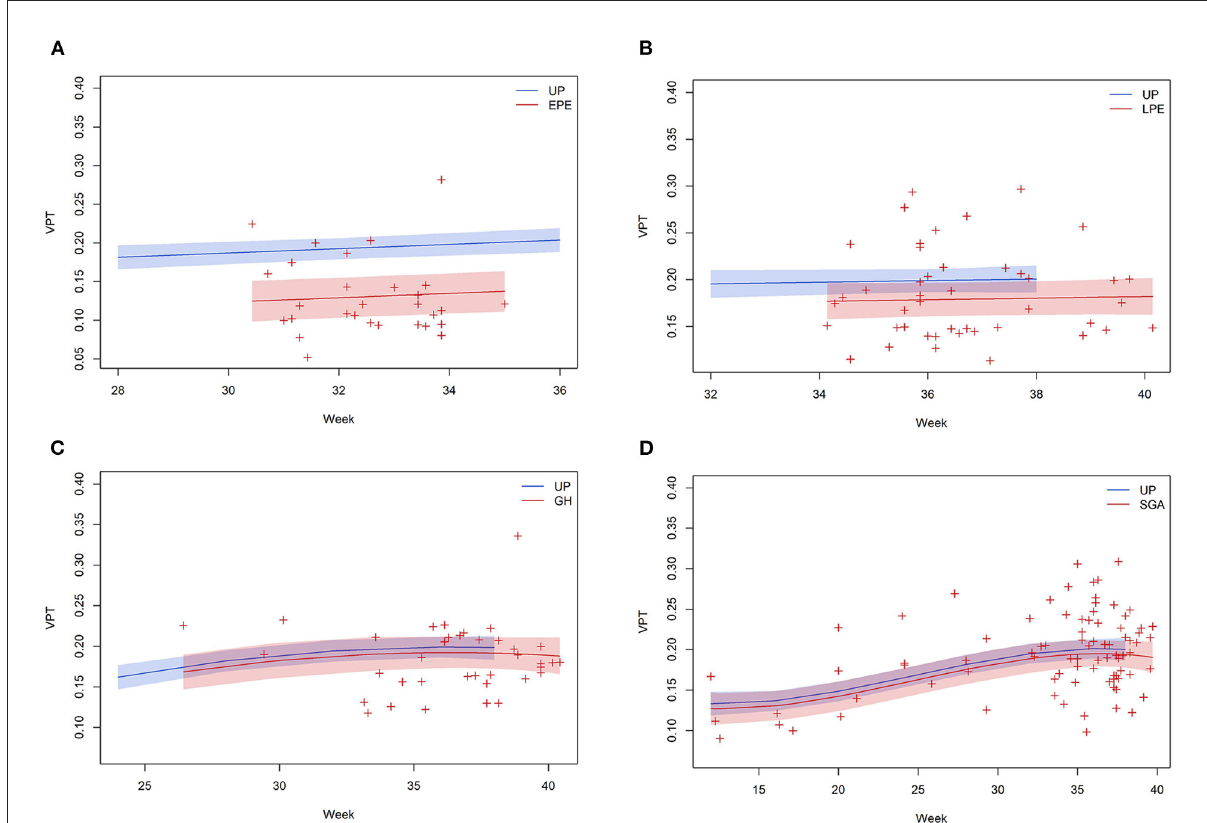
FIGURE1 Evolution of VPT as measured at right distal IJV in EPE (A) , LPE (B) , GH (C) , and SGA (D) relative to gestational age and plotted against the reference values of 41